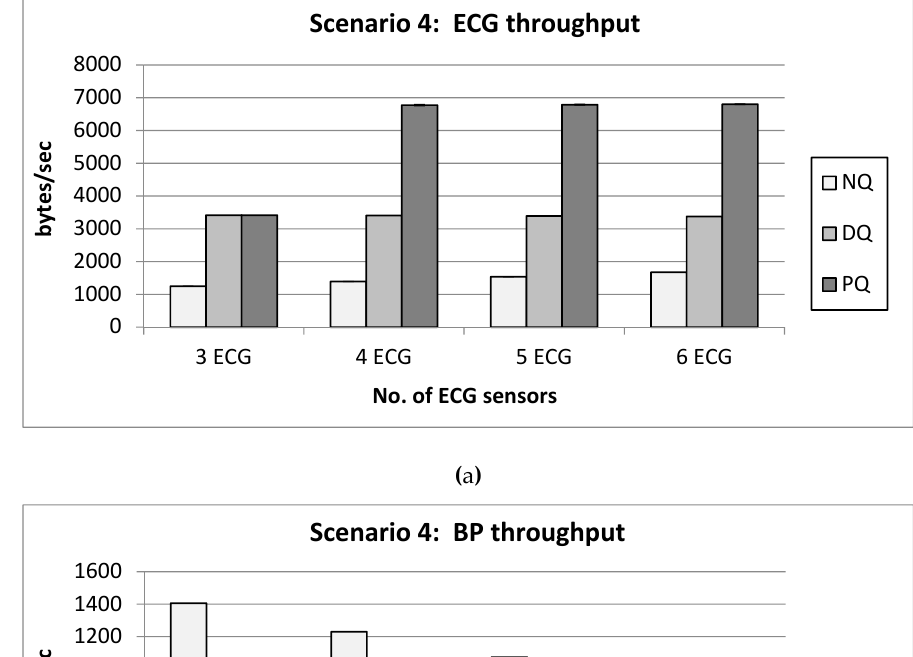
Figure 12. Average end-to-end packet delay results comparison for various data traffic types .